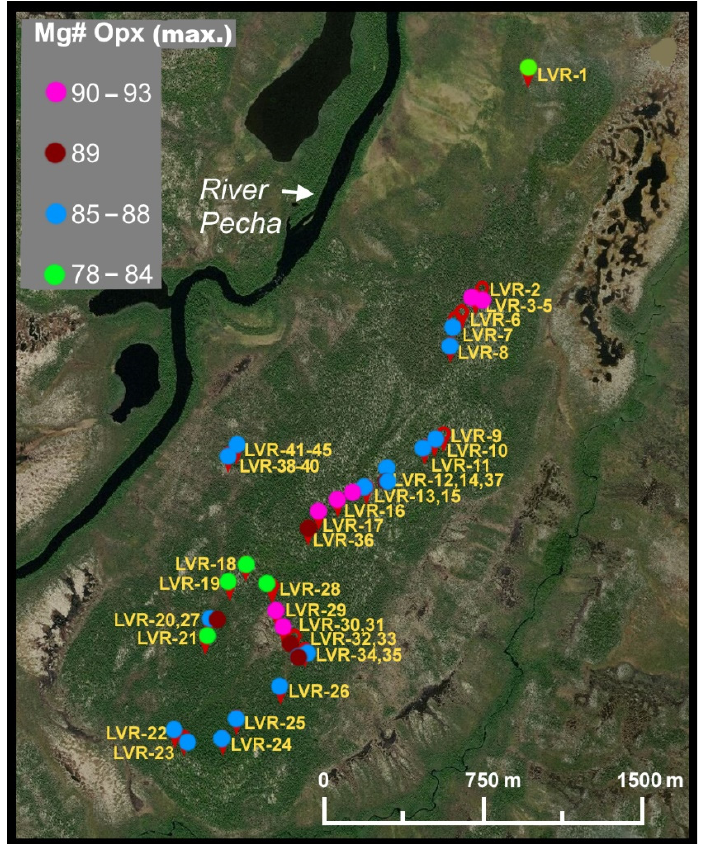
Figure 2. The location of our samples [18], plotted on a satellite image, is coded to indicate schematically the maximum value of the Mg# index, i.e., 100 Mg/(Mg + Fe + Mn), in orthopyroxene, Opx. The most primitive samples are cumulates, members of the ultrabasic core, here labeled Zone I: LVR29–35. The bulk of the samples pertain to the orthopyroxene-dominant Zone II (LVR1–17, 22–25, and 36–45). Sample LVR26, a pegmatitic orthopyroxenite, is located close to the inferred boundary with Zone I. Samples LVR18–20, 21, 27 and 28 are the most evolved, and they belong to Zone III, in which